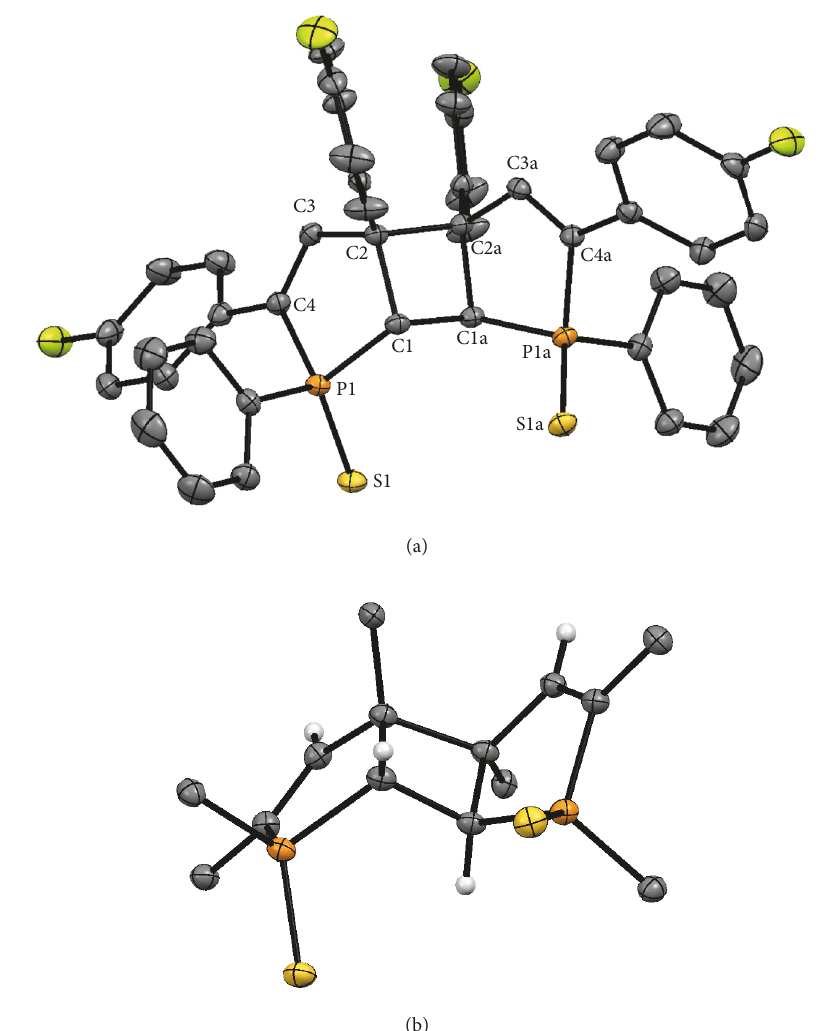
Figure 1: Molecular structureof 5d : (a) top-view of whole molecule with 50% probability ellipsoids; hydrogens and solvent molecule omitted for clarity; (b) side-view of tricyclic [ 5;4;5] pattern showing the syn-anti arrangement.